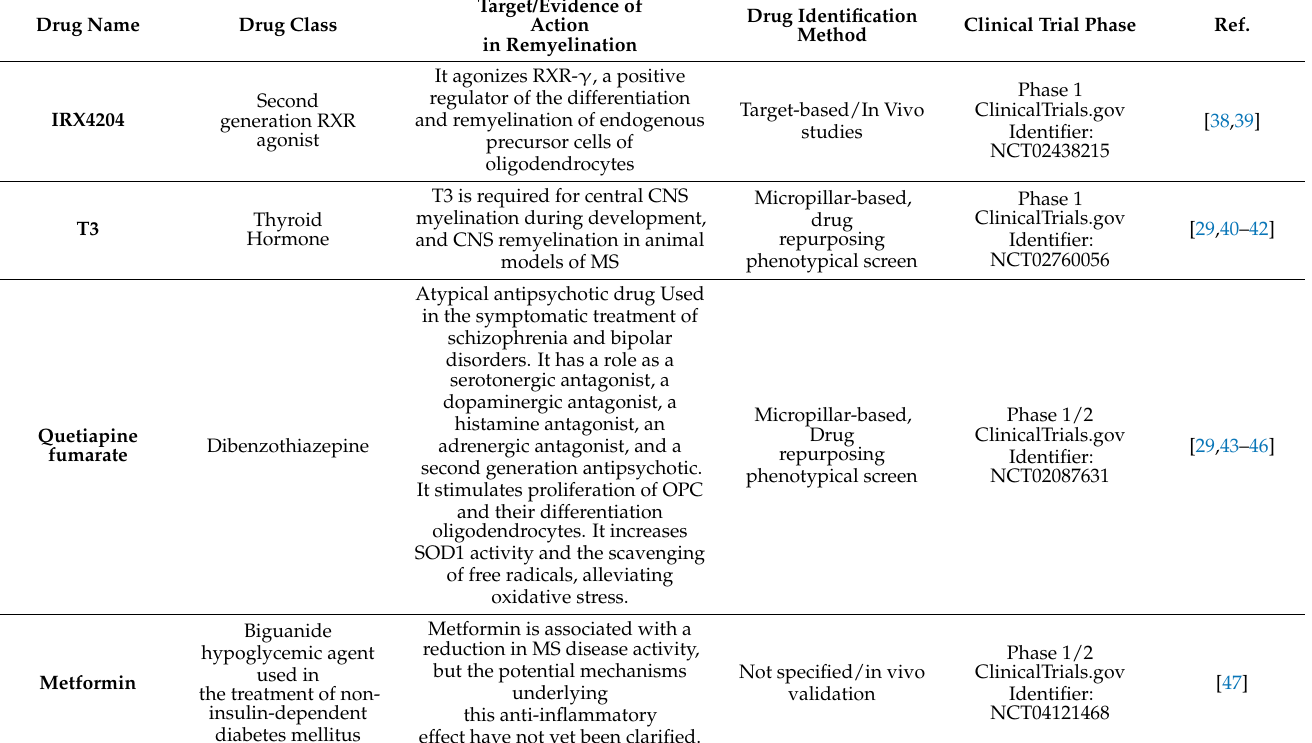
Table 1. Drugs promoting CNS remyelination in preclinical studies tested in clinical trials. List of drugs implicated in remyelination currently in clinical trials. The compounds are listed on the basis of the clinical study phase. Data were obtained from https://clinicaltrials.gov/ct2/home (accessed on 10 November 2020) and